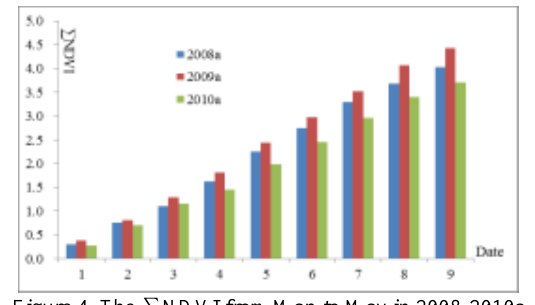
Figure 4. The ∑ NDVI from Mar. to May in